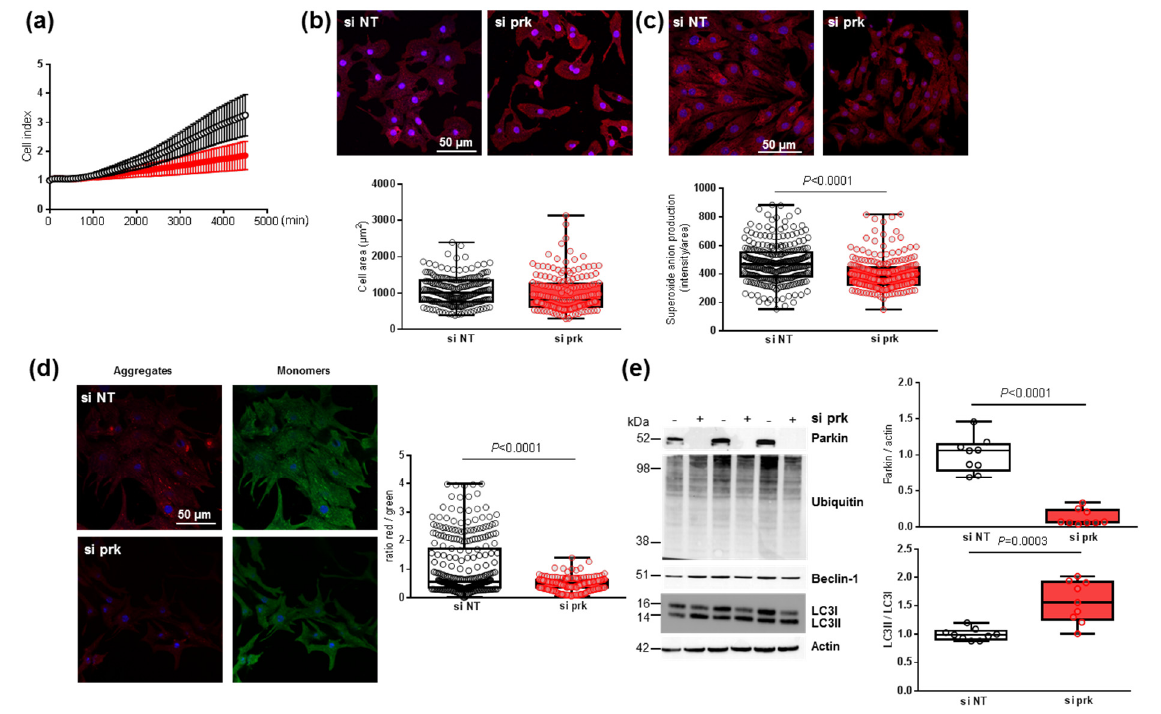
Figure 7. Effect of parkin depletion on hypertrophy, oxidative stress, mitochondrial biogenesis and mitophagy in neonatal rat cardiomyocytes (NCMs). ( a ) Cell index quantification by RTCA analysis in NCMs transfected with the siRNA specifically targeting rat parkin mRNA (si prk, red line) or the non-targeted siRNA (si NT, black line) as control. Cell index was recorded every 15 min ( n = 2 independent isolations, in quadruplicate). ( b ) Hypertrophy was quantified by immunofluorescence of alpha-actinin (red) and nuclei (blue) and quantification of cell area (µm 2 ) (from 3 independent experiments and at least 178 cells). ( c ) Mitochondrial superoxide anion was quantified by fluorescence quantification of mitoSOX (red) (from 3 independent experiments and at least 249 cells ( d ) Mitochondrial membrane potential was quantified by fluorescence quantification of JC-1 dye (aggregates (red) and monomer (green)) (from 3 independent experiments and at least 257 cells). ( e ) Mitophagy was quantified in NCMs transfected with the si prk (+) or si NT ( − ) as control. by Western blot of Parkin, ubiquitinated proteins, Beclin-1 and LC3II/LC3I ratio. Data were normalized to HPRT for RNA and actin for protein. Only significant p values are indicated from at least 3 independent experiments. Images were selected to represent the mean values of each condition.